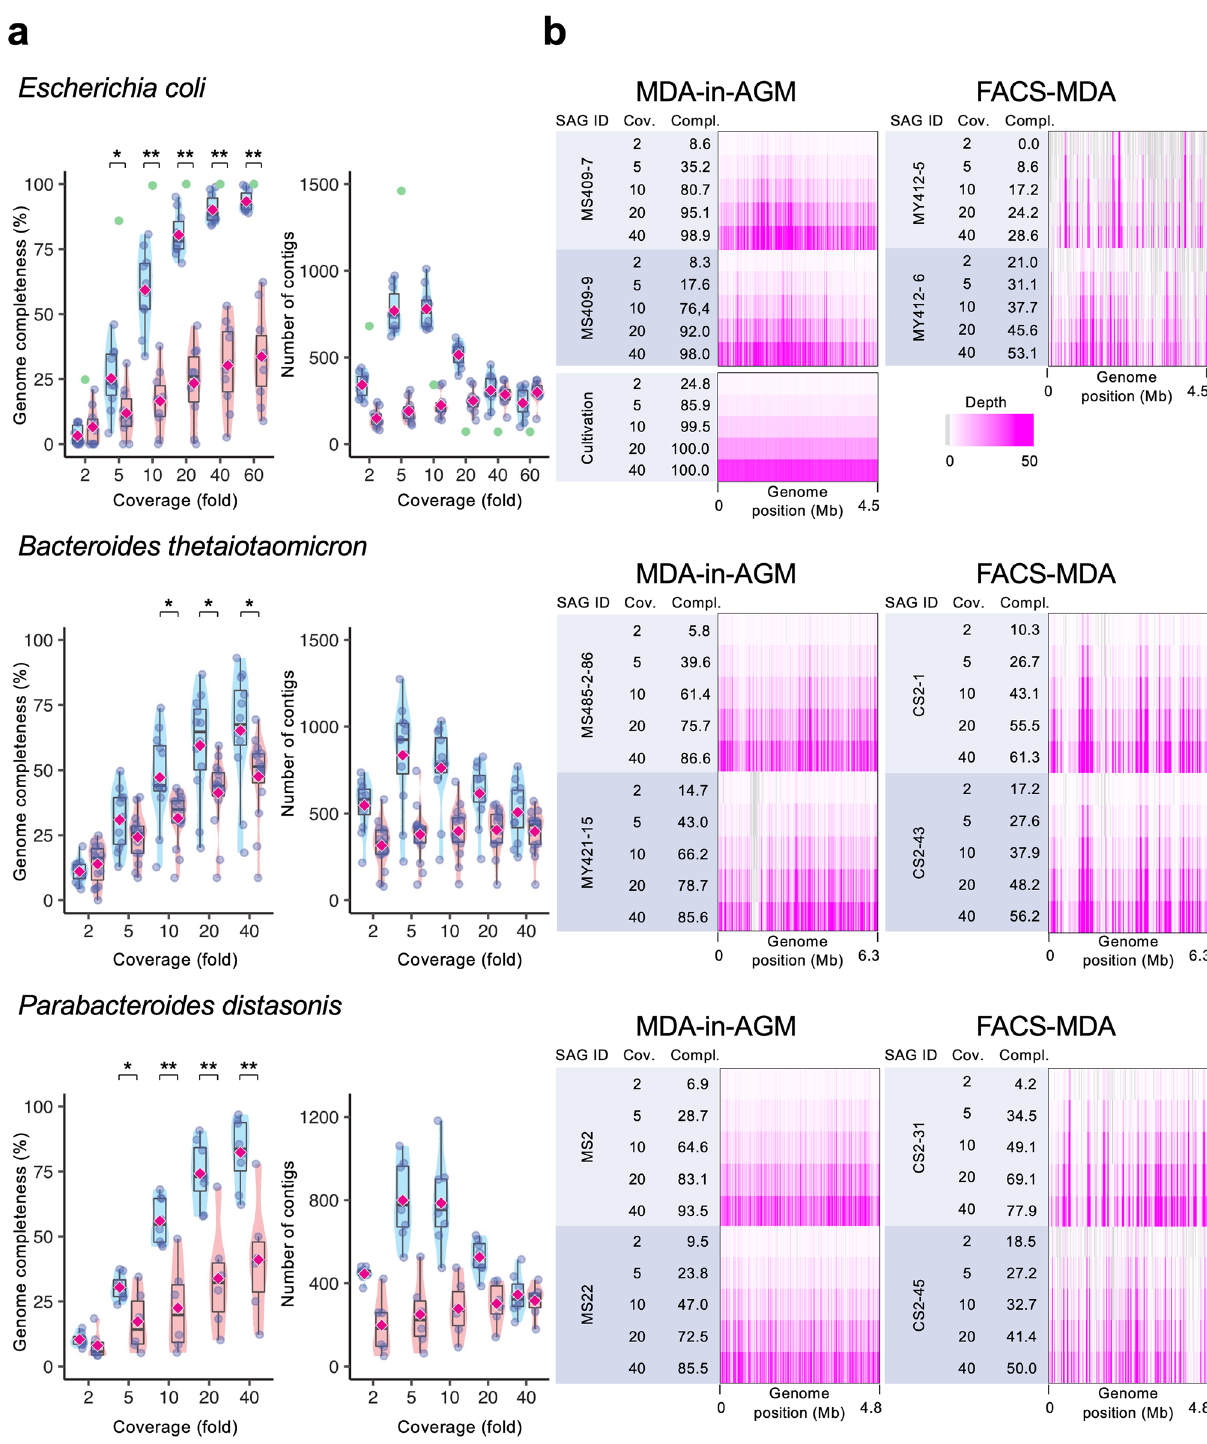
Figure 3. Comparison of genome completeness and amplification bias of single-cell genomes obtained by MDA-in-AGM and FACS-MDA. ( a ) Completeness and number of contigs of SAGs during the sequencing process. Box-and-violin plots (blue: MDA-in-AGM; red: FACS-MDA) are shown for Escherichia coli and two bacterial species as examples from the mock community of human gut bacteria (Supplementary Tables S2, S5 and S6). Datapoints (purple circles) and their arithmetic means (rhombuses) are shown on the plots. In the E. coli graphs, the results for DNA prepared from cultured E. coli cells without MDA are also shown (green circles). In the left panels, significant differences are indicated with asterisks ( P < 0.05) or double asterisks ( P < 0.01). ( b ) The number of sequence reads mapped against genome regions is shown as an indicator of amplification bias caused during MDA. The numbers of reads corresponding to different coverages used for de novo assembly (shown as ‘Cov.’) and genome completeness (%) (‘Compl.’) estimated using CheckM are